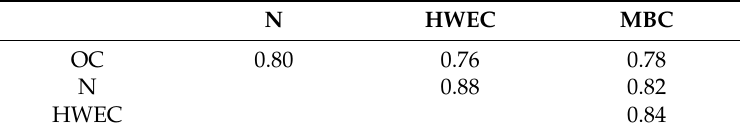
Table 2. Correlation matrix (Pearson’s r) for studied soil properties ( n =